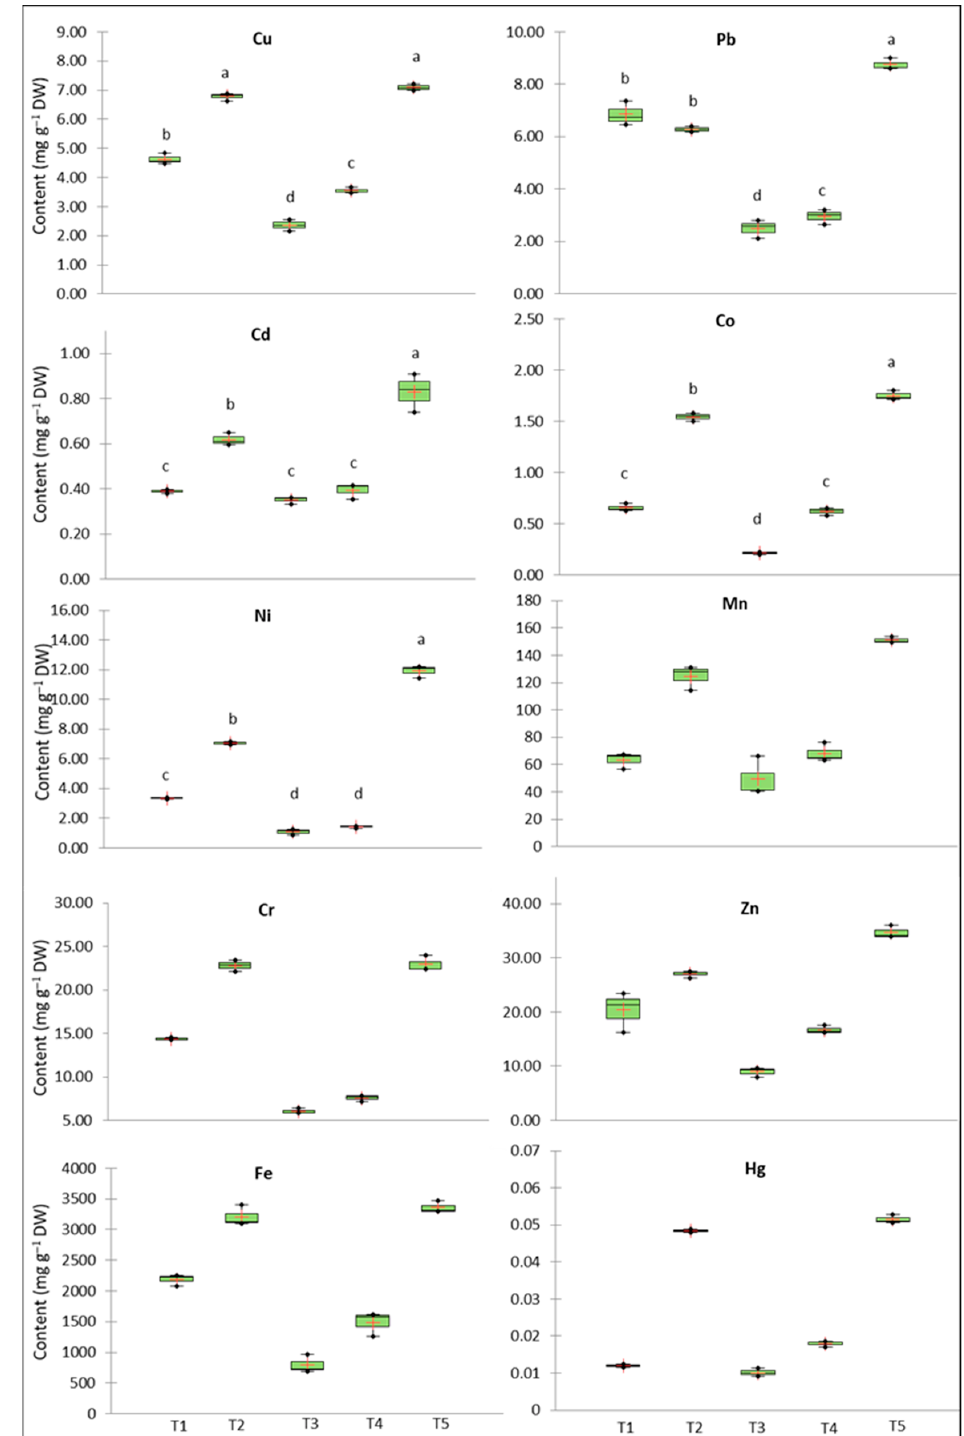
Figure 2. Content of elements in the sediment of Lake Bohinj. Di ff erent le tt ers indicate signi fi cant di ff erences between plots (ANOVA with the Tukey post hoc test, p < 0.05).